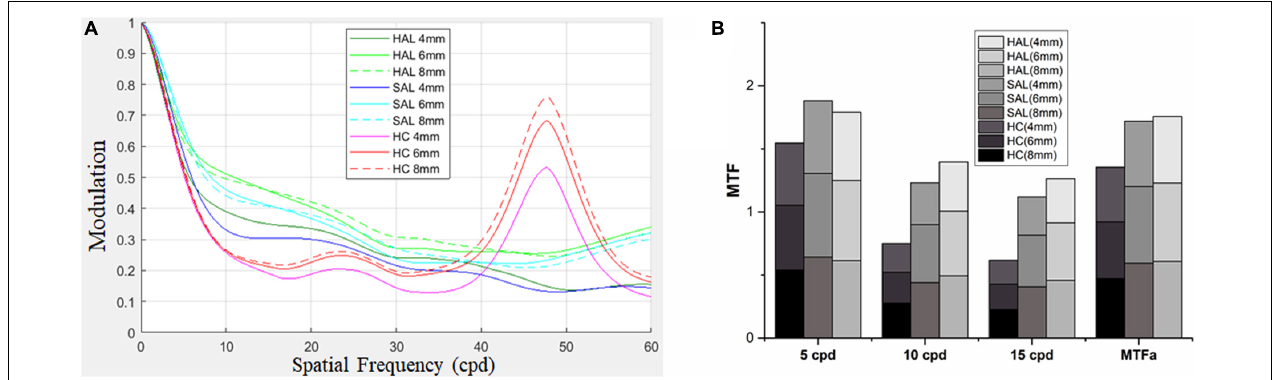
FIGURE 5 | For lenses of HAL, SAL, and HC, MTFs were computed for three pupil apertures of 4, 6, and 8 mm (A) . MTFs at 5, 10, and 15 cpd, and MTFa from 0 up to 15 cpd at the three pupil apertures are shown in (B) . HAL, highly aspherical lenslets; SAL, slightly aspherical lenslets; HC, honeycomb configuration of spherical lenslets; MTF, modulation transfer function; MTFa, MTF area; cpd, cycle per